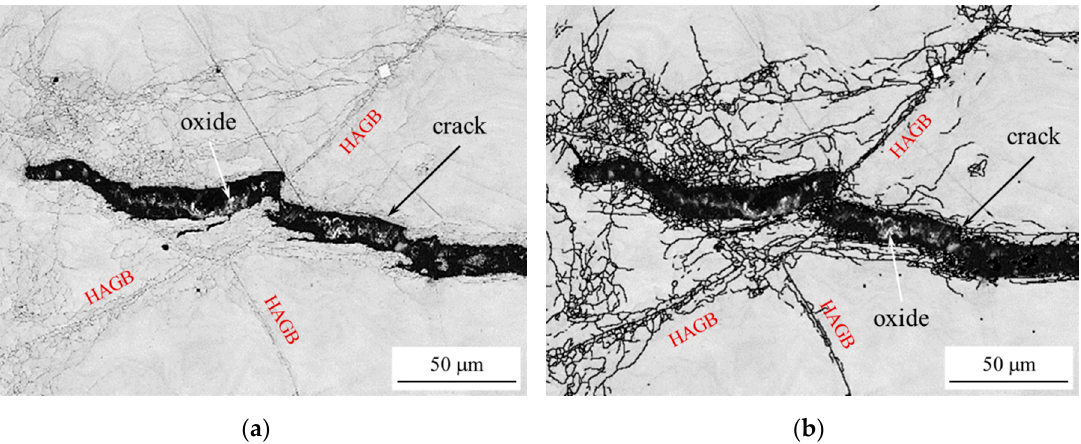
Figure 9. Limited sub-grain formation in close vicinity of a crack tip in ferritic Crofer ® 22 H after TMF failure: SEM image ( a ) and EBSD band contrast image with fatigue-induced sub-grain boundaries (misorientation definition angle: >3°, step size: 0.438 μ m) added ( b ). HAGB denotes pre-existing high angle grain boundaries.